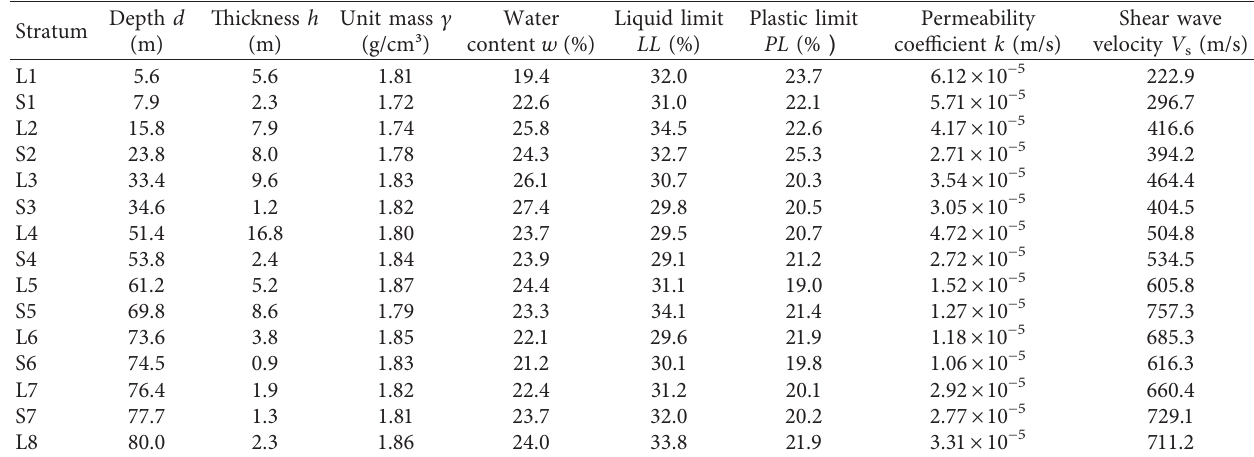
Table 1: Physical parameters of the experimental